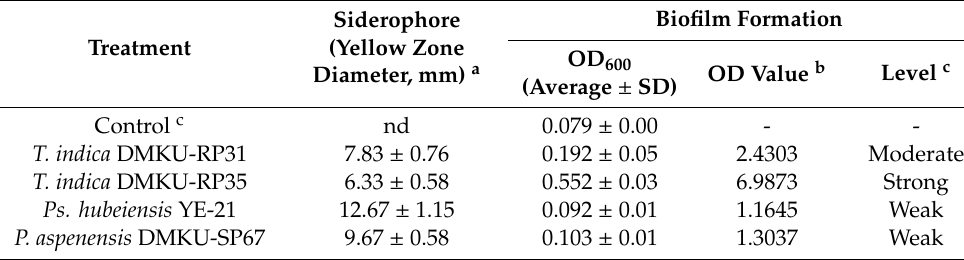
Table 2. Siderophore production and biofilm formation by the antagonistic yeast strains .